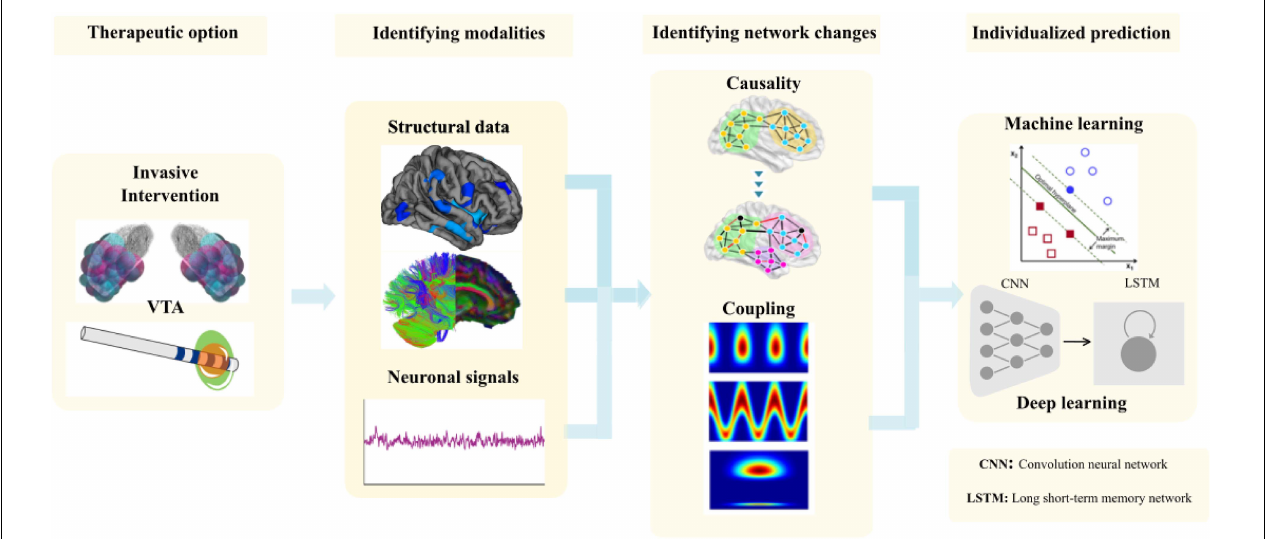
FIGURE 8 | The methodological framework to entangle network proxies for prediction of the outcome of the DBS patients from volume of tissue activated (VTA) modeling to identifying the correct modalities to identify the network changes and use it for individual prediction using matching learning